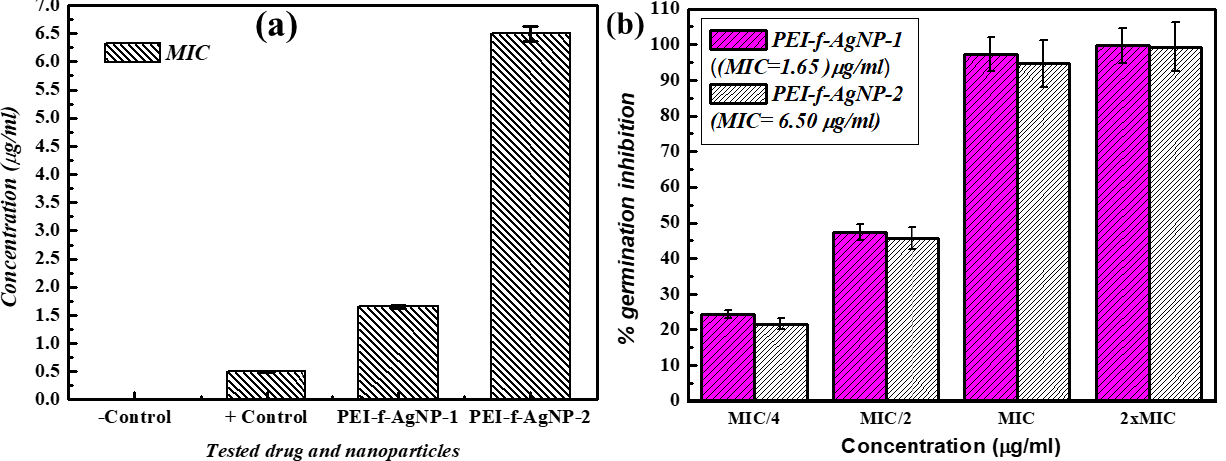
Figure 5. Minimum inhibitory concentration of PEI-f-Ag-NPs against sporangiospores of R. arrhizus. ( a ) and ( b ) representing the % sporangiospores germination inhibition by PEI-f-Ag-NPs in a dose- dependent manner (PEI-f-AgNP-1 MIC/4 = 0.41, MIC/2 = 0.82, MIC = 1.65, and 2 × MIC= 3.30 μ g/mL) and PEI-f-AgNP-2 (PEI-f-AgNP-2 MIC/4 = 1.62, MIC/2 = 3.25, MIC = 6.50, and 2 × MIC= 13.0 μ g/mL). Data are presented as per cent error bar.